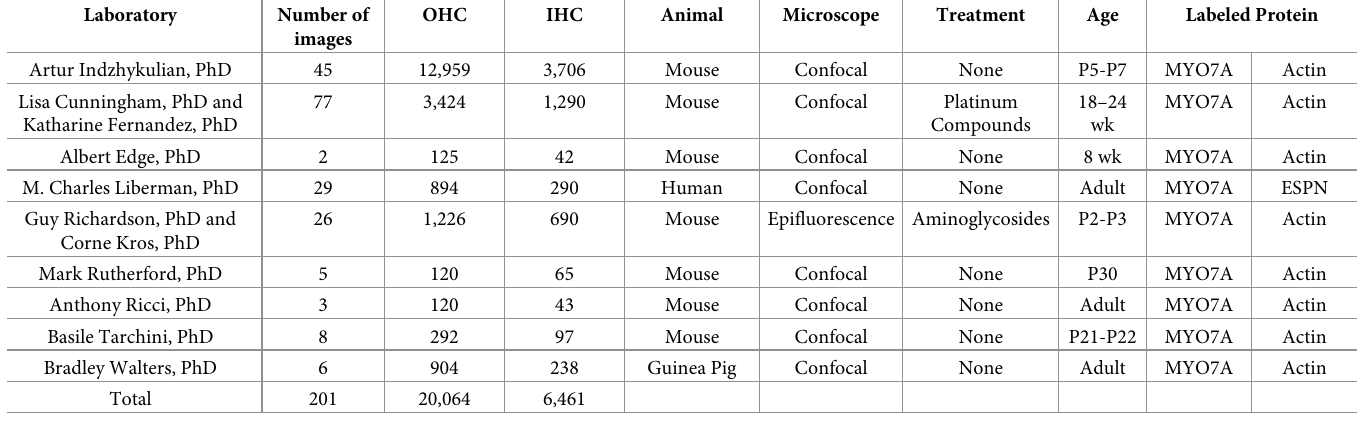
Table 1. Summary of training